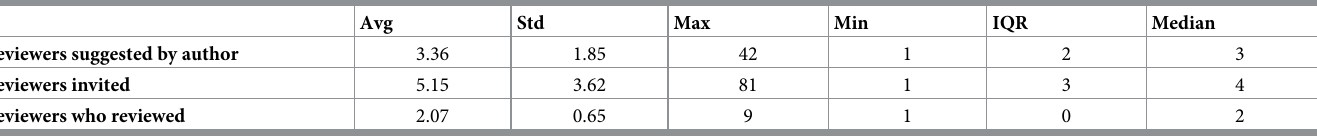
middle, and last names. Using a set of 120 manually labeled datapoints, the method achieved a